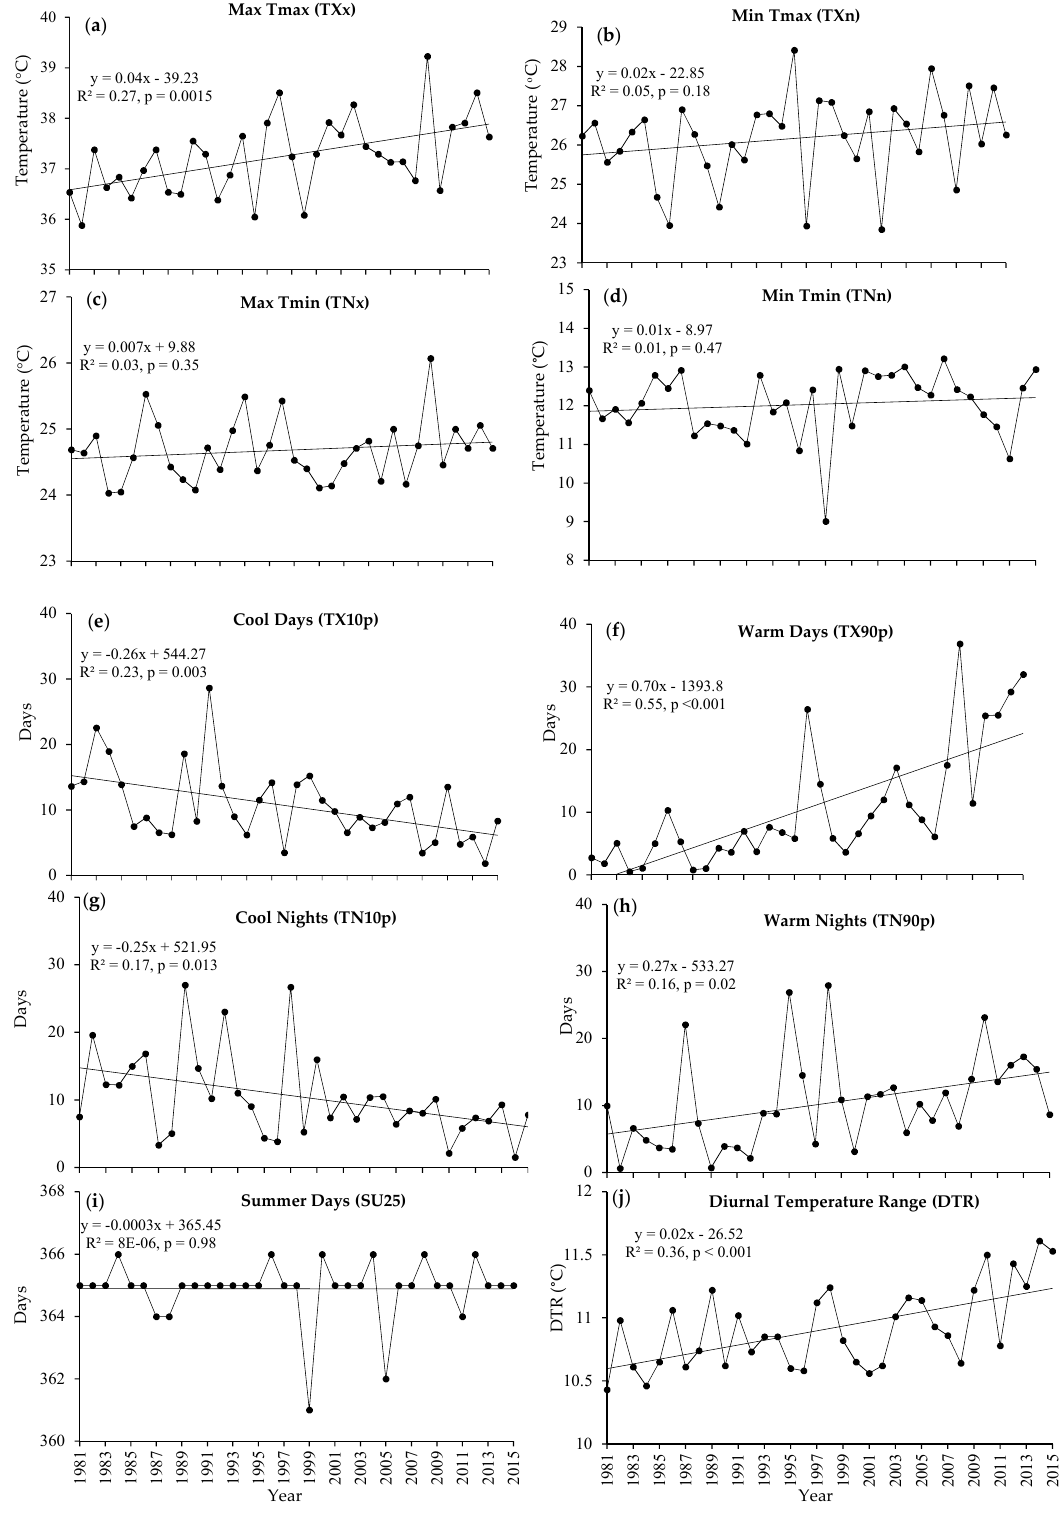
Figure 5. Annual trends of country-wide averaged temperature indices ( a ) TXx; ( b ) TXn; ( c ) TNx; ( d ) TNn; ( e ) TX10p; ( f ) TX90p; ( g ) TN10p; ( h ) TN90p; ( i ) SU25; and ( j ) DTR for the period 1981–2015.